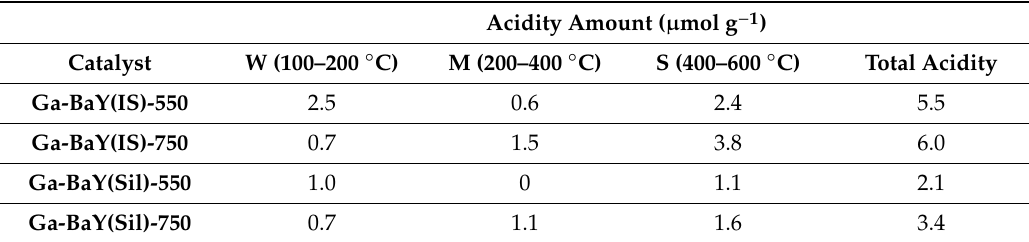
Acid properties of zeolites calcined at di ff erent temperatures studied by NH 3 -temperature-programmed desorption